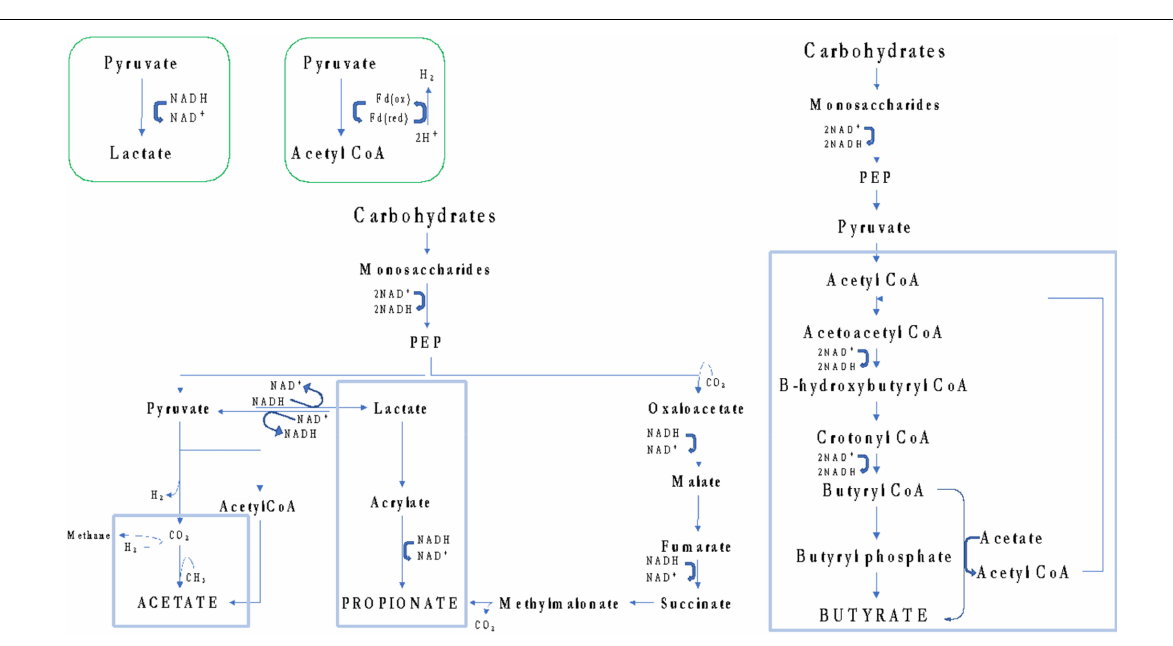
FIGURE 3 | Schematic overview of pathways that gut microbes can use to synthesize acetate, propionate, and butyrate from